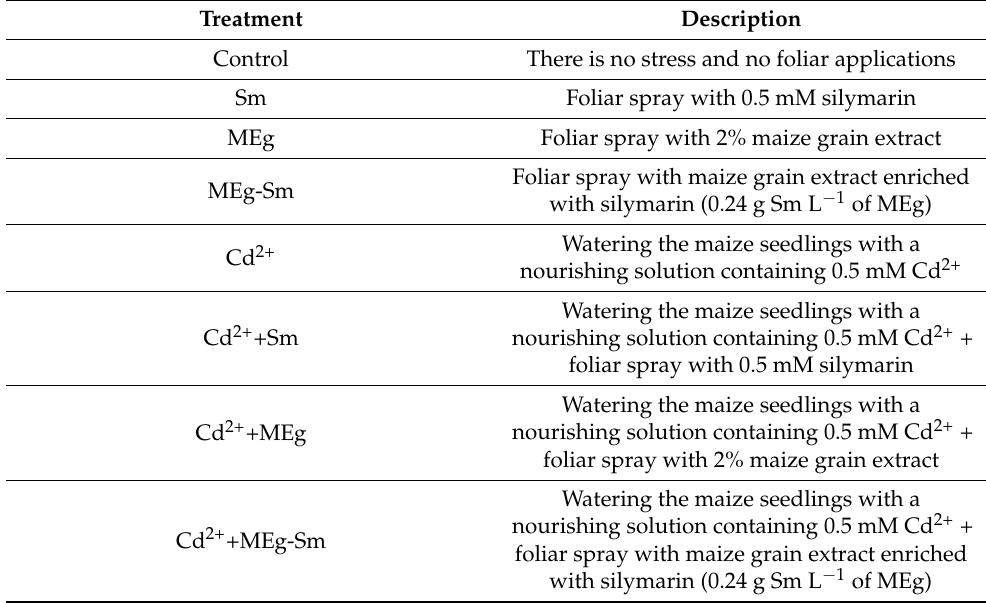
Table 2. The experimental treatment